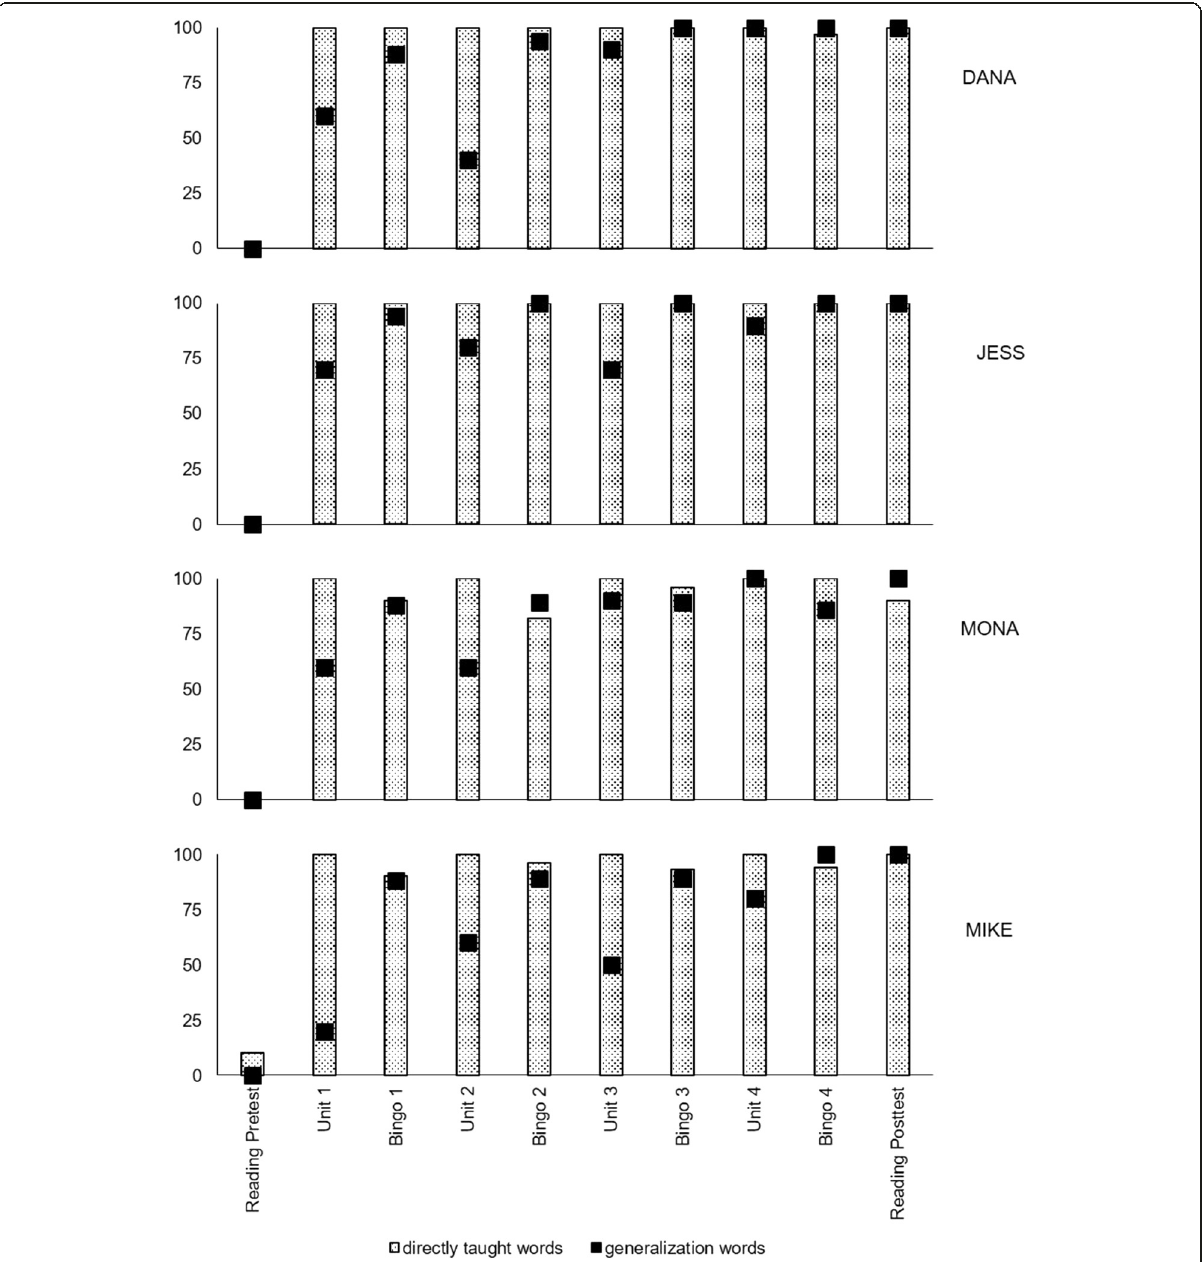
Fig. 3 Percentage of correct reading responses in directly taught and generalization trials in bingo games and in the unit posttests of the